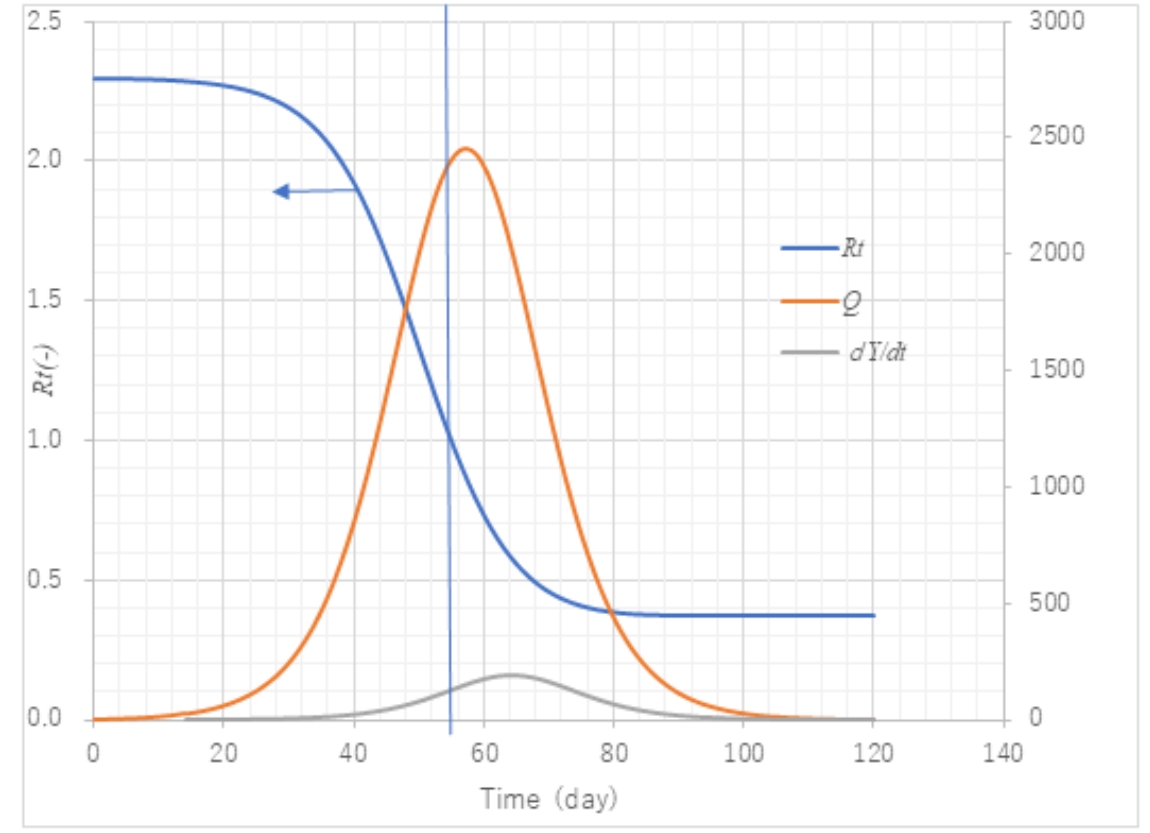
Figure 6. Trends of the reproductive number, R t , infectious cases at large, and daily new confirmed cases. Model PART1 with the same parameter values as in Figure 3 was used. The value of R t is on the left axis and the other variables, infectious cases at large (Q) and daily new confirmed cases (dY/dt), are on the right axis. The vertical line represents the date when R t =1, which almost coincides with the date maximum Q is reached. This verifies the expression of R t